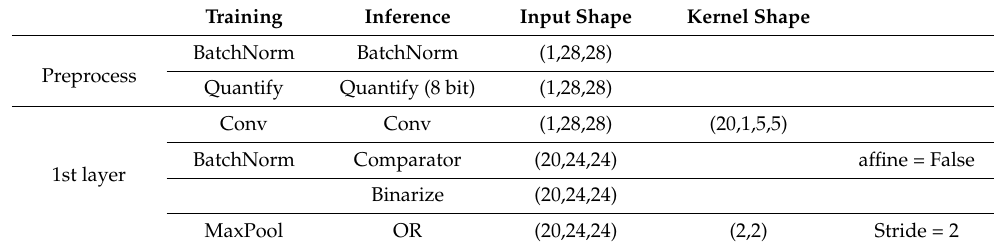
Table 2. Network parameter configuration in Model II (only parameters different from Model I are